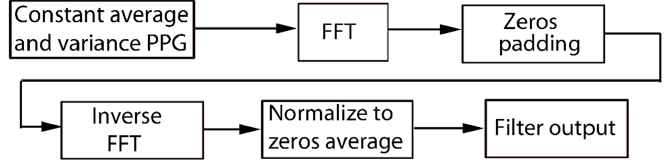
Figure 5. ( a ) Normalized PPG signal in SPW and ( b ) its spectrum. Figure 6. The block diagram of signal fast Fourier transform (FFT) filtering algorithm.